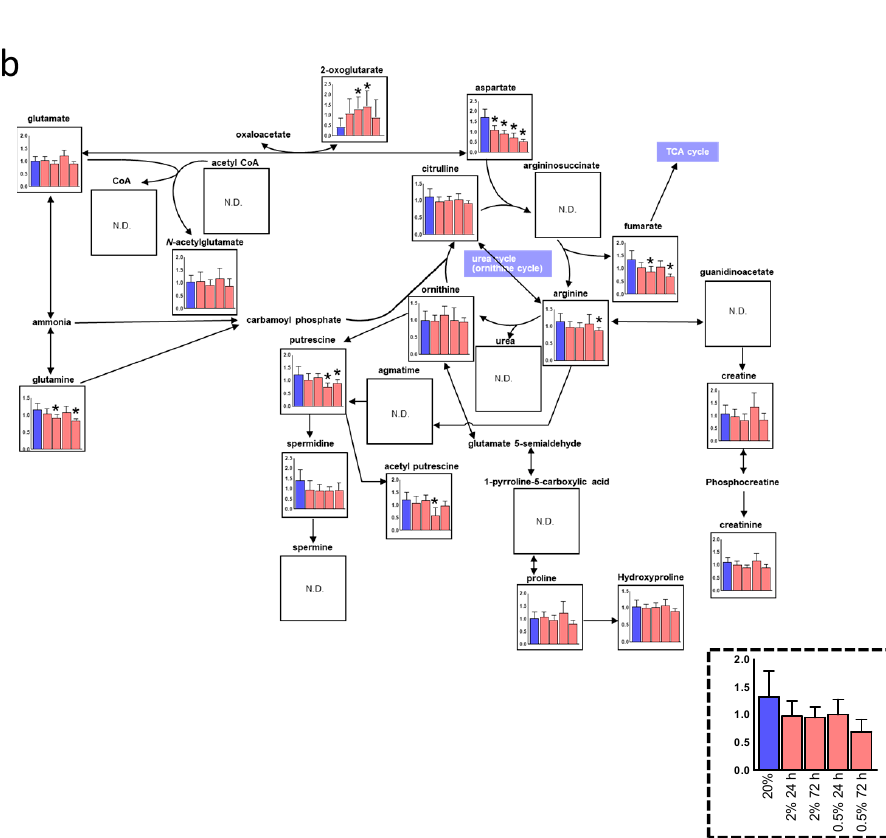
Figure 4. Metabolic pathway maps of the urea cycle of oral keratinocytes ( a ) and oral fibroblasts ( b ) in hypoxic culture ( n = 6). Quantified metabolite concentrations are shown as bars; ambient oxygen cultured (blue), 2% O 2 for 24 h, 2% O 2 for 72 h, 0.5% O 2 for 24 h, and 0.5% O 2 for 72 h, from left, respectively. p -values were calculated using Student’s t -test (two-tailed, unequal variance). * p < 0.05 was shown for comparison between each data for 20%